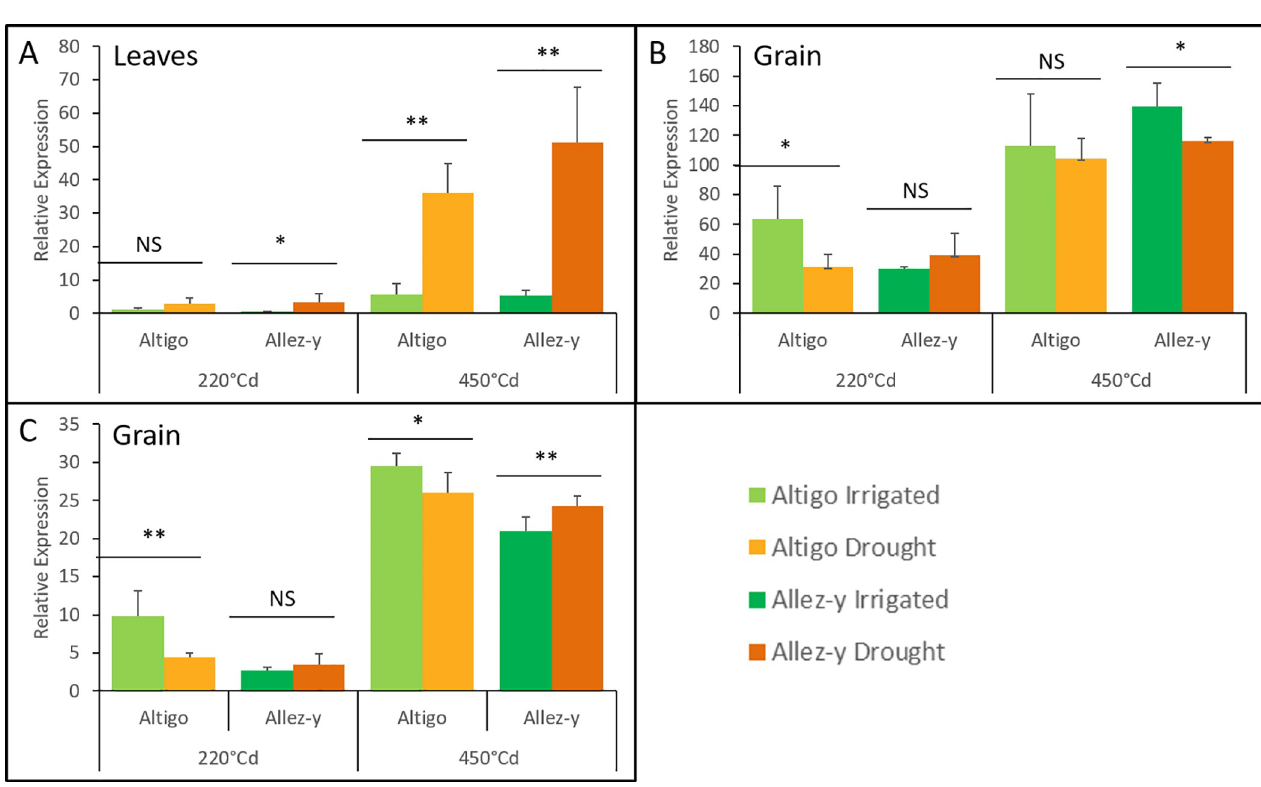
Fig 9. RT-qPCR expression analysis of TraesCS5A01G143200.1 (A), TraesCS5A01G245900.2 (B), and TraesCS7A01G569100.1 (C). The 2 - ΔΔ Ct method was used to calculate the ratio of their relative expression levels in drought conditions with the one in irrigated conditions. Mean values and standard deviation were obtained from three replicates (Student’s T test, � indicates a P < 0.05 and �� indicates a P < 0.01).